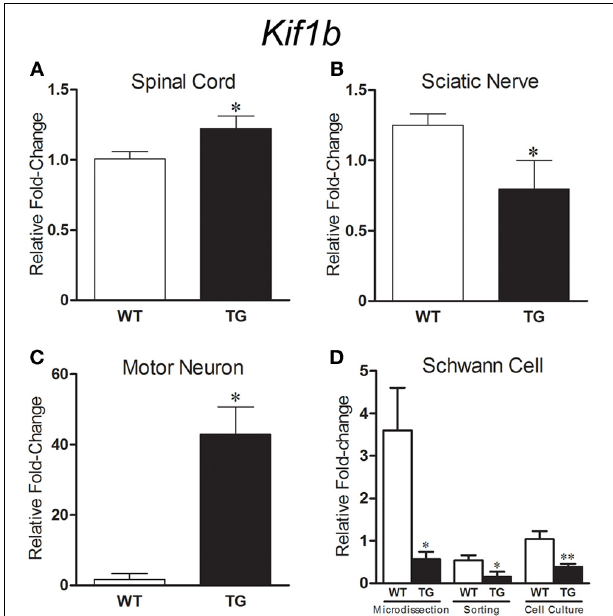
FIGURE 5 | Graphs show relative fold change values for Kif1b in SOD1 G93A (TG) and age matched wild-type controls (WT) mice by means of qPCR. Gene expression differences in the spinal cord [40 days old, (A) ], sciatic nerve [60 days old, (B) ] and microdissected motor neurons [40 days old, (C) ] are pointed. Kif1b expression was downregulated in sciatic nerve Schwann cell [60 days old, (D) ] enriched samples from microdissection, flow cytometry sorting and cell culture procedures. Means ± SEM from four samples of each group. ∗ and ∗∗ p -values, < 0.05 and < 0.01, respectively, according to unpaired t